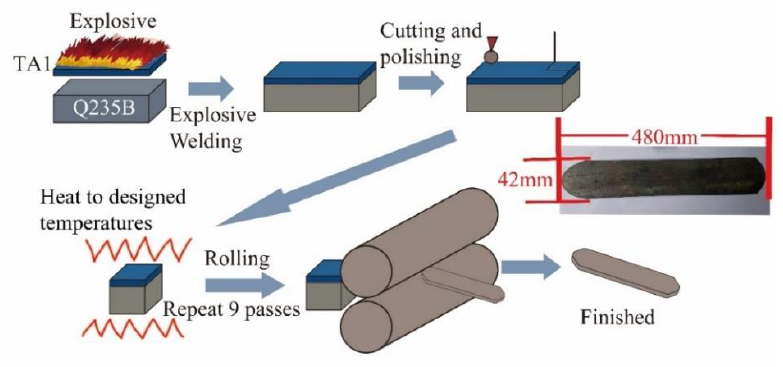
Figure 1. Schematic diagram of the preparation process of 2-mm-TA1 / Q235B composite sheets. Table 2. The thickness and reduction of TA1 / Q235B Sheets.